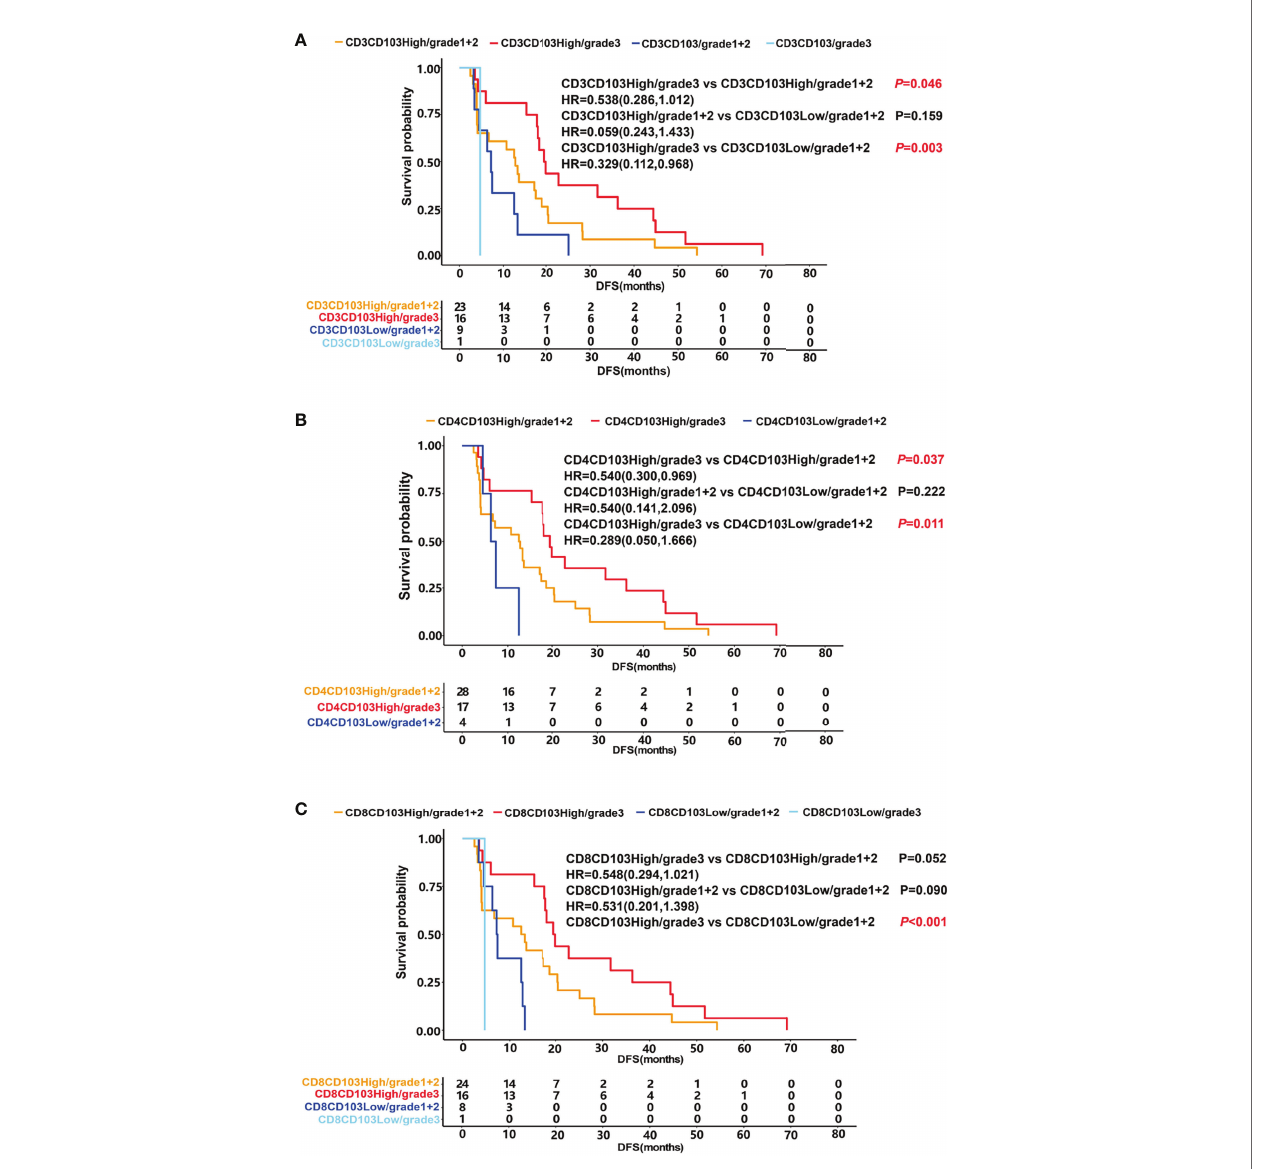
FIGURE 5 | The relationship between T RM , patient score and prognosis. DFS was shown with Kaplan – Meier plots according to the combination of T RM and patient score. (A) DFS of patients in the group of CD3CD103 High and grade 3 (median 19.7 months) was signi fi cantly higher than that of CD3CD103 High and grade 1 + 2 (median 12.7 months) and that of CD3CD103 Low and grade 1 + 2 (median 7.2 months), respectively, P <0.05. (B) DFS of patients in the group of CD4CD103 High and grade 3 (median 19.5 months) was signi fi cantly higher than that of CD4CD103 High and grade 1 + 2 (median 12.6 months) and that of CD4CD103 Low and grade 1 + 2 (median 6.9 months), respectively, P <0.05. (C) . DFS of patients in the group of CD8CD103 High and grade 3 tended to be better than that of CD8CD103 High and grade 1 + 2 (median 19.7 months vs. 12.8 months, P =0.052), and signi fi cantly higher than that of CD8 CD103 Low and grade 1 + 2 (median DFS 19.7 months vs. 7.3 months, P <